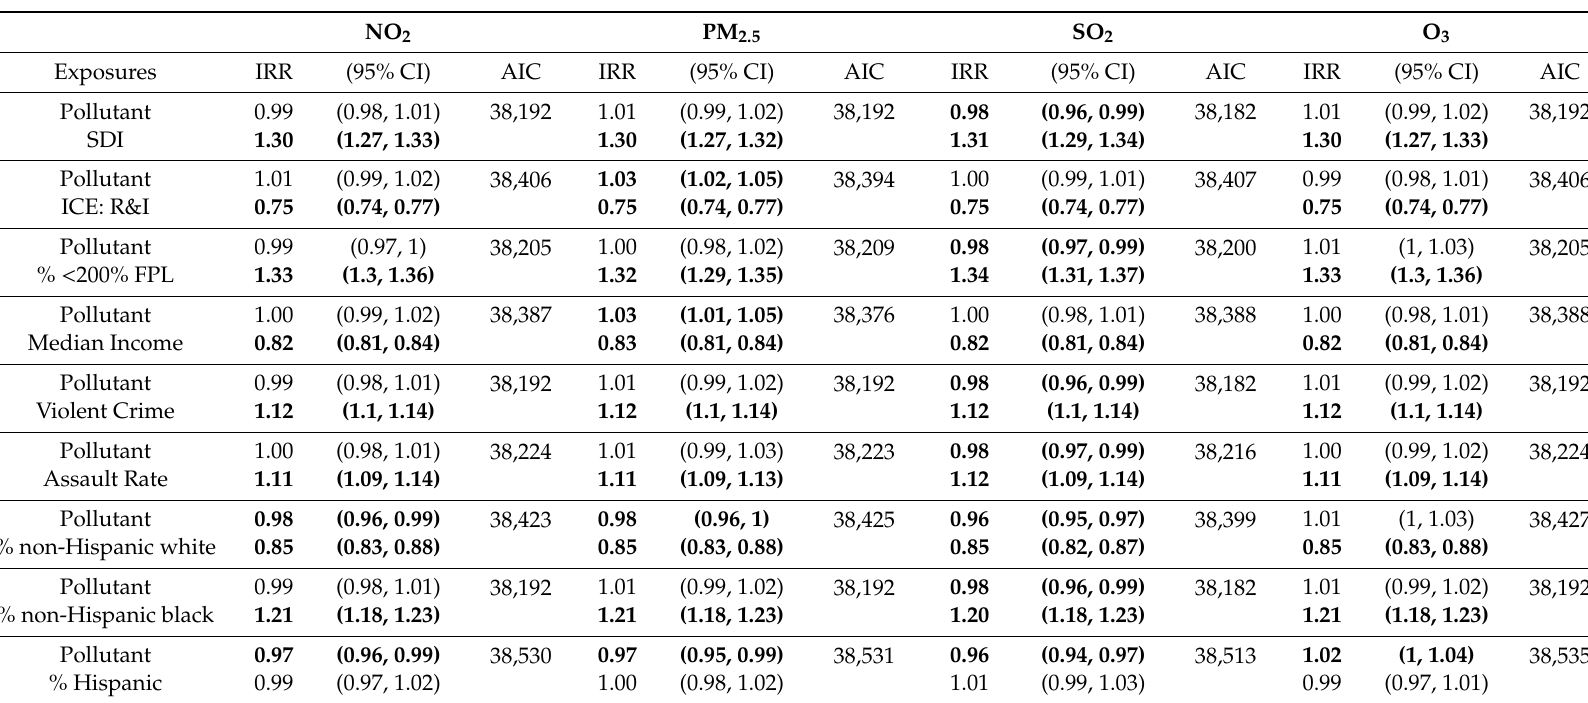
Table 5. Fully-adjusted negative binomial models for each pollutant-social factor combination vs. census tract CVD rate, additionally adjusted for the strongest predictor of CVD from the other two social factor categories (SDI in the economic / material deprivation category, Violent Crime Rate in the exposure to crime category, and / or % non-Hispanic black in the racial / ethnic composition category). Incident rate ratio (IRR) represents the change in CVD incidence rate per 1-IQR change in each covariate. Bolded values indicate statistical significance after adjusting the false discovery rate. N =